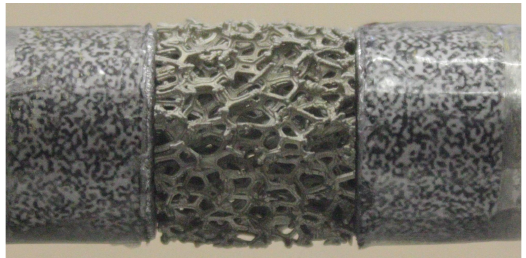
Figure 1. Ni/PU foam specimen in the SHPB exper- imental setup